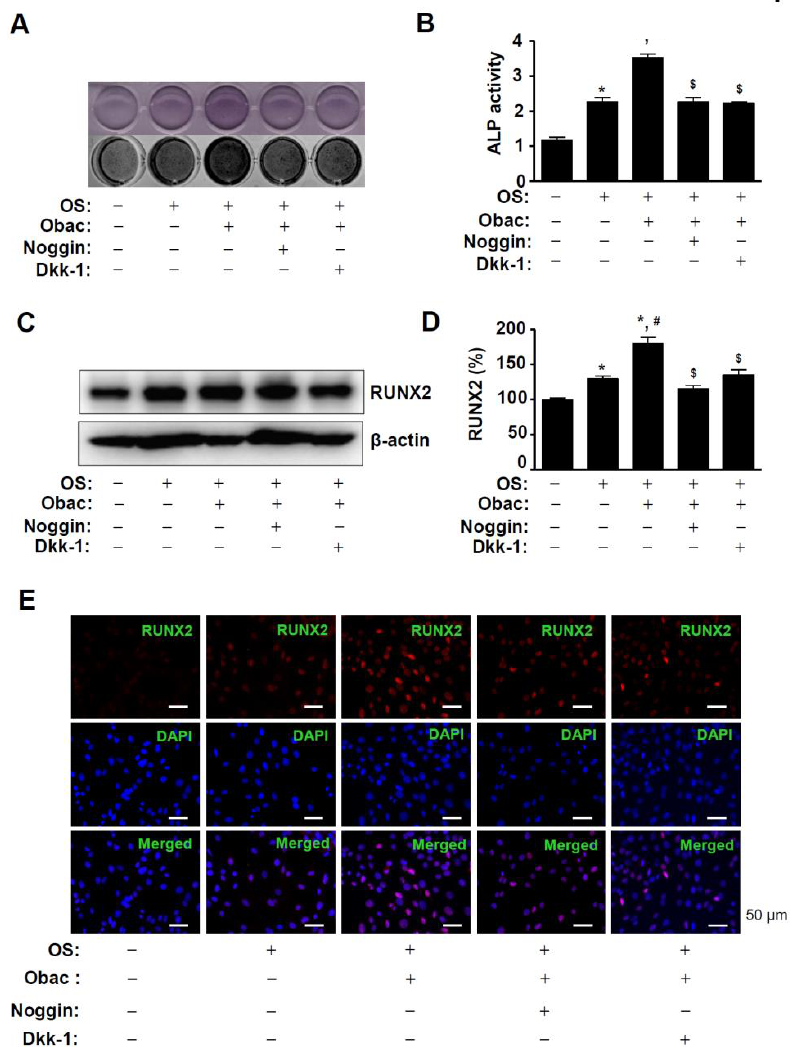
Figure 6. Effects of Obac-induced osteoblast differentiation and RUNX2 expression through the inhibition of BMP2 and β -catenin signaling. ( A , B ) MC3T3-E1 was incubated in OS with 10 µ M Obac in the absence or presence of noggin (10 µ g/mL) and Dkk-1 (0.5 µ g/mL) for 7 days. ALP staining was detected using a scanner (upper) and a colorimetric detector (bottom) ( A ), and ALP activity was assessed using ALP activity colorimetric assay ( C ). ( C , D ) After 48 h, the expression of RUNX2 was assessed using Western blot analysis ( C ). β -actin was detected on the same sample to normalize the values, and the data were expressed as a bar graph ( D ). ( E ) After 48 h, the nuclear localization of RUNX2 were assessed using Immunofluorescence. The first panels show RUNX2 expression (red), the second panels show DAPI (a nuclear marker, blue), and the bottom panels show the merged images of the first and second panels. Scale bar: 50 µ m. Data are representative of three independent experiments, and values are expressed in the mean ± S.E.M. * p < 0.05 indicates statistically significant differences, compared with the control. #: statistically significant differences compared with OS ( # p < 0.05). $: statistically significant differences compared with the OS + Obac ( $ p <